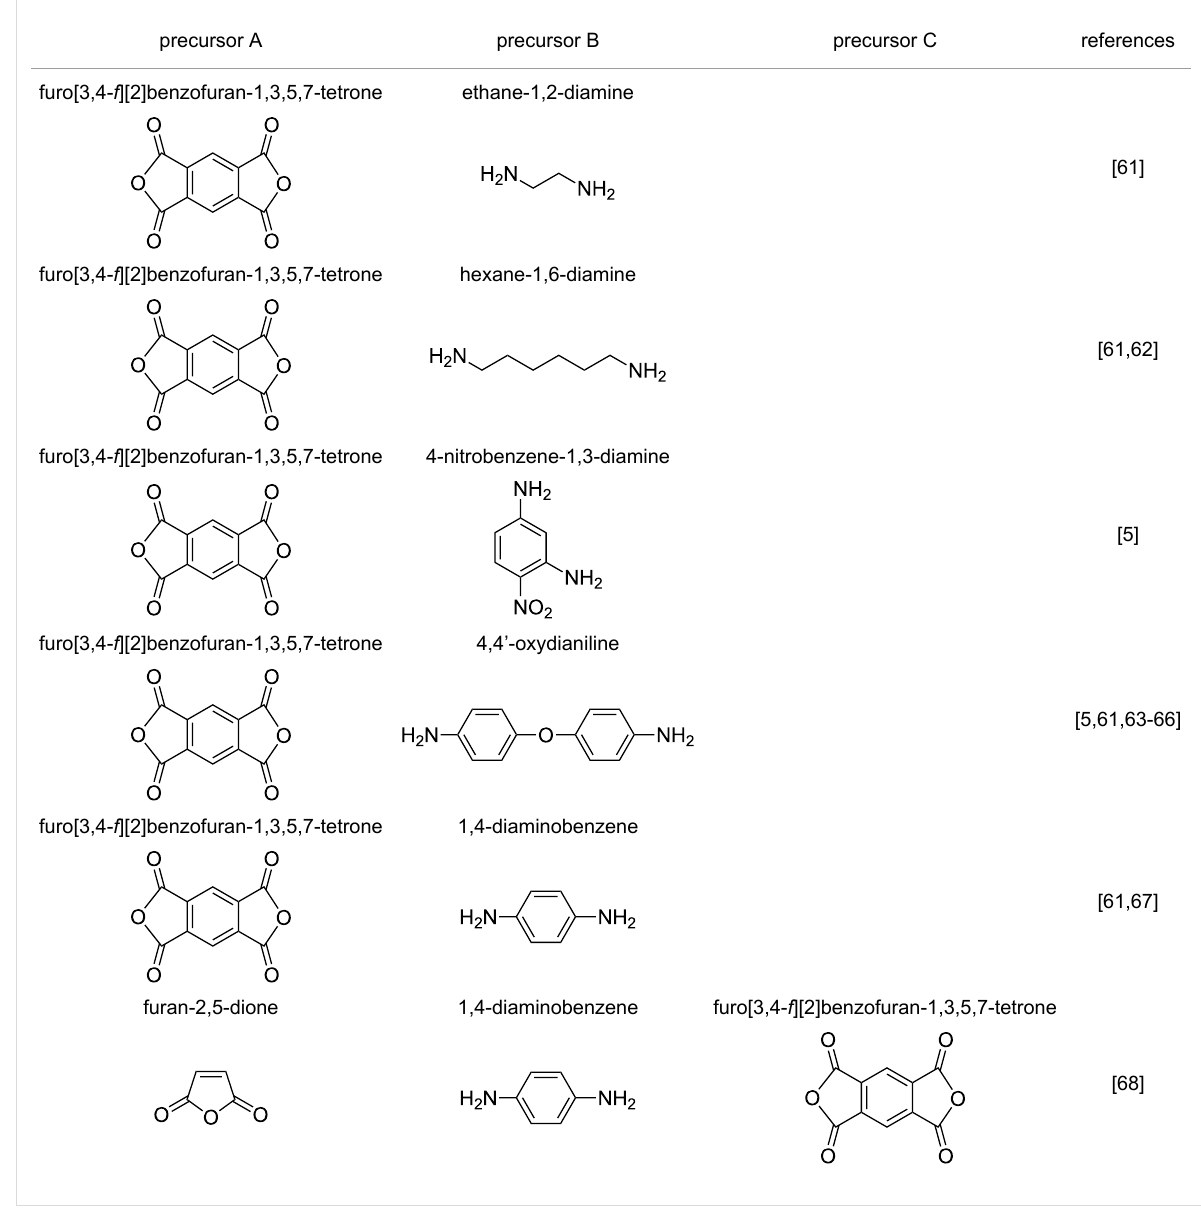
Table 4: Precursors used to deposit polyimide thin